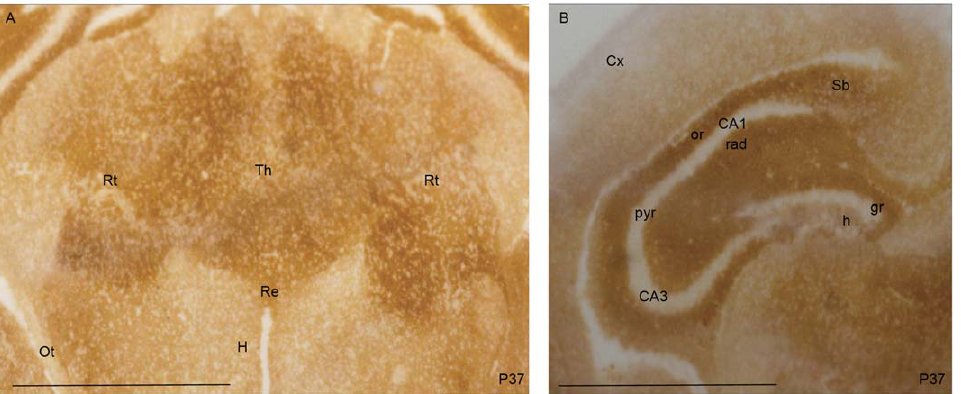
Figure 4. PrP C distribution in a P37 opossum brain. (A–B) Coronal sections in the caudal diencephalon from a P37 opossum were stained for PrP C in the thalamus (Th) and in the parenchyma of the hippocampus. (A) In the ventral thalamus, a strong IR was observed in the reticular nucleus (Rt) and in the nucleus reuniens (Re). No IR was observed in the optic tract (Ot). In the hypothalamic area (H) the immunoreactivity was lower than in the thalamus. (B) A strong PrP C signal was observed in the stratum oriens (or) and in the stratum radiatum (rad) of the hippocampus. A low PrP C immunoreactivity was observed in the hilar region (h), while the pyramidal (pyr) and granule (gr) cell layers of the CA1-CA3 and DG were devoid of immunostaining (Bars: 1 mm).